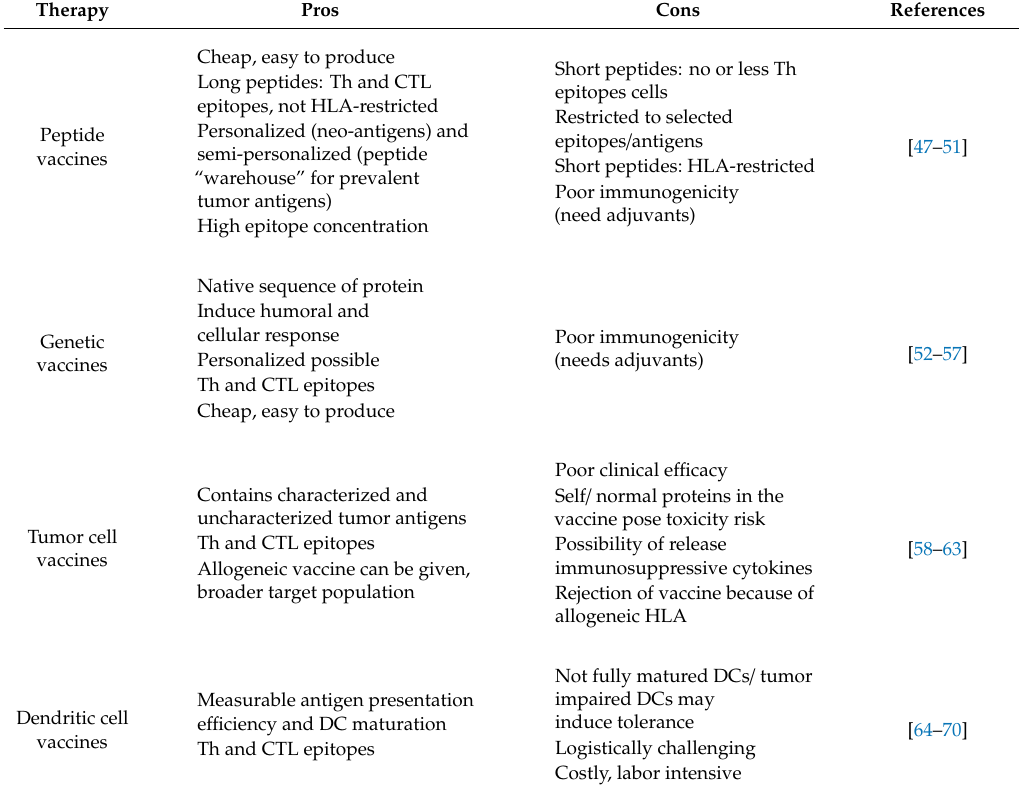
Table 1. Overview of conventional cancer vaccines with pros and cons.